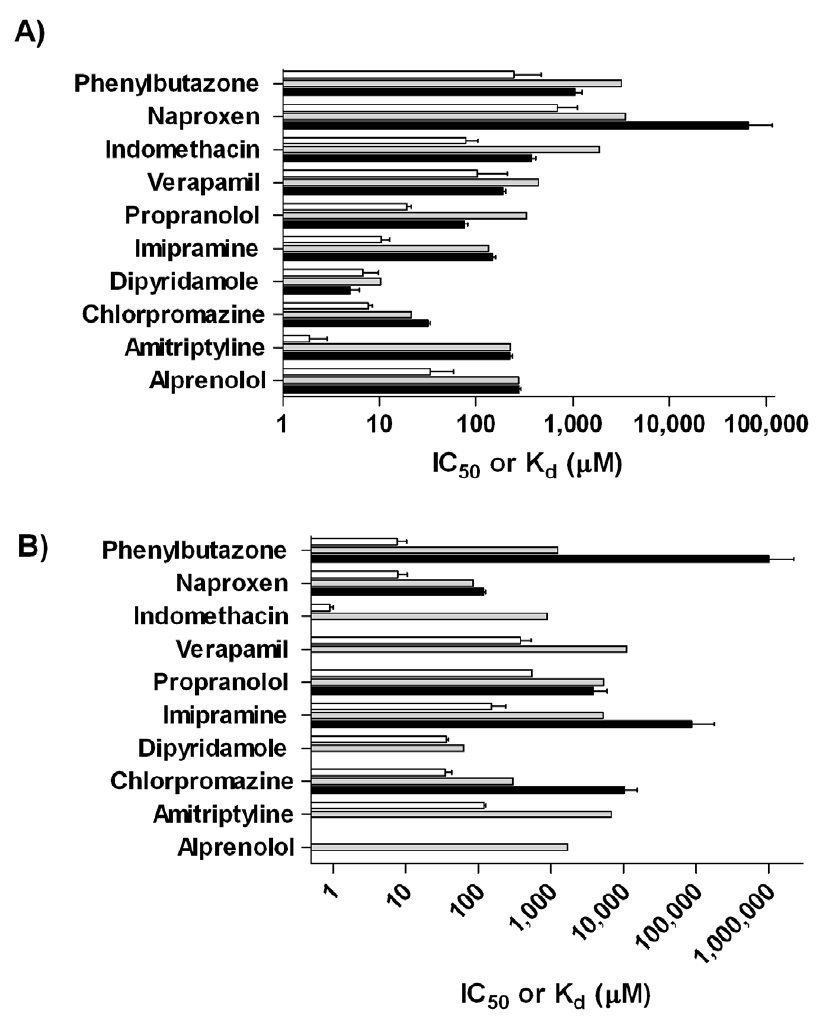
Figure 6. Validation Set Testing. A) IC 50 and K d values for the Validation Set in 1,536-well ( & ), 96-well ( & ), and protein coated bead ( % ) AGP assays; B) the corresponding results for the HSA